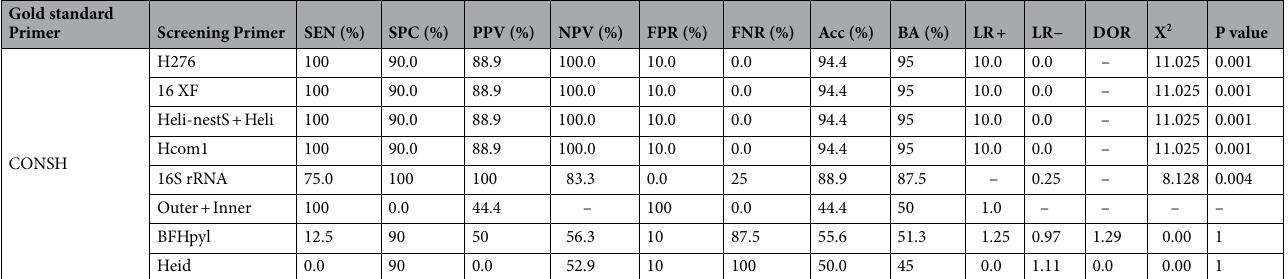
Table 4. Laboratory evaluation of the primers validity for the detection of Helicobacter spp. (n = 8) and Non- Helicobacter spp. (n = 10). SEN: sensitivity; SPC: specificity; PPV: Positive predictive value; NPN: Negative predictive value; FPR: False positive rate; FNR: False-negative rate; ACC: Accuracy; BA: Balanced accuracy; LR + : Positive likelihood ratio; LR−: Negative likelihood ratio; DOR: Diagnostic odds ratio.